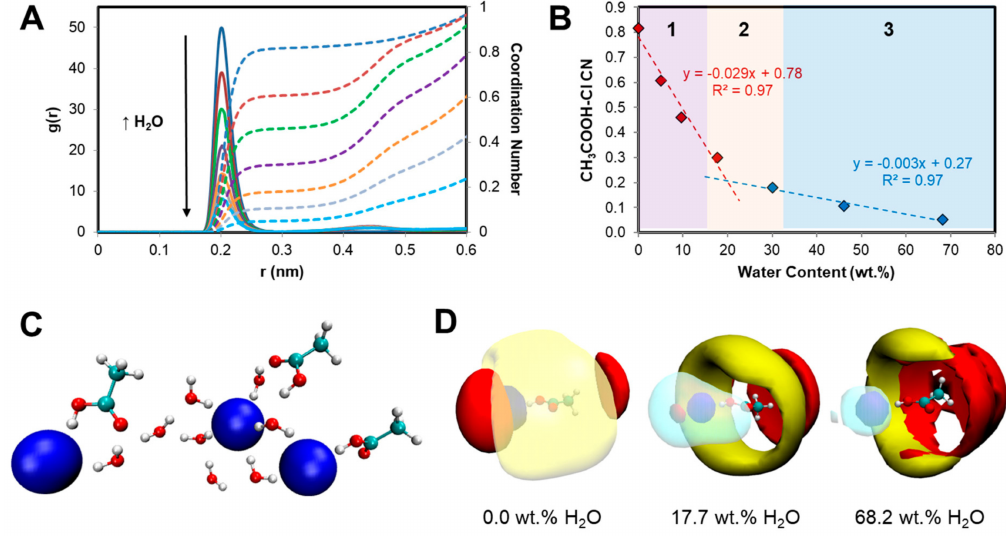
Figure 3. ( A ) RDFs of the CH 3 COOH ··· Cl − with increasing water content (reference atoms for acetic acid were OH) and ( B ) corresponding coordination numbers (region 1 and 3 are monophasic whilst region 2 corresponds to the experimentally determined biphasic regime). ( C ) A representative snapshot of water-in-IL hydrated clusters for 5.1 wt.% H 2 O. ( D ) Spatial density function plots of the various system components around acetic acid for three water concentrations (Cl − —blue; [P 44414 ] + —yellow; CH 3 COOH—red; H 2